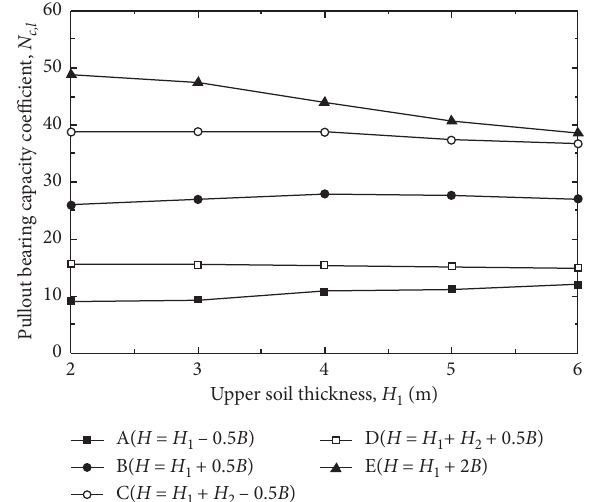
Figure 7: Variation in the pullout bearing capacity coefficient at different embedment depths ( H 1 � 3 B , H 2 � 3 B , α � 0.3).